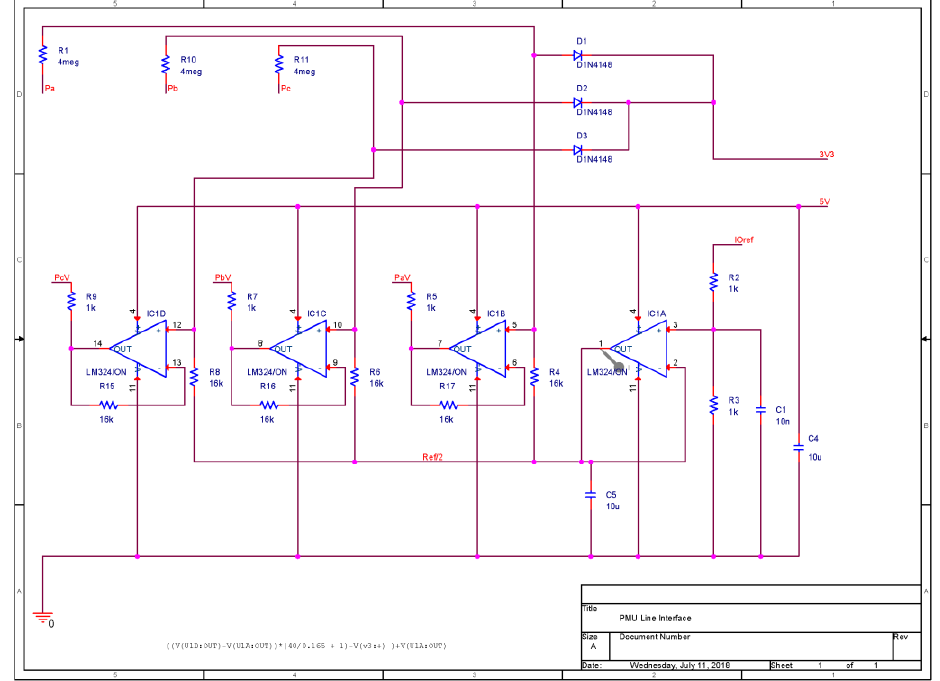
Figure 10. Schematic diagram of the proposed PMU line voltage interface module.